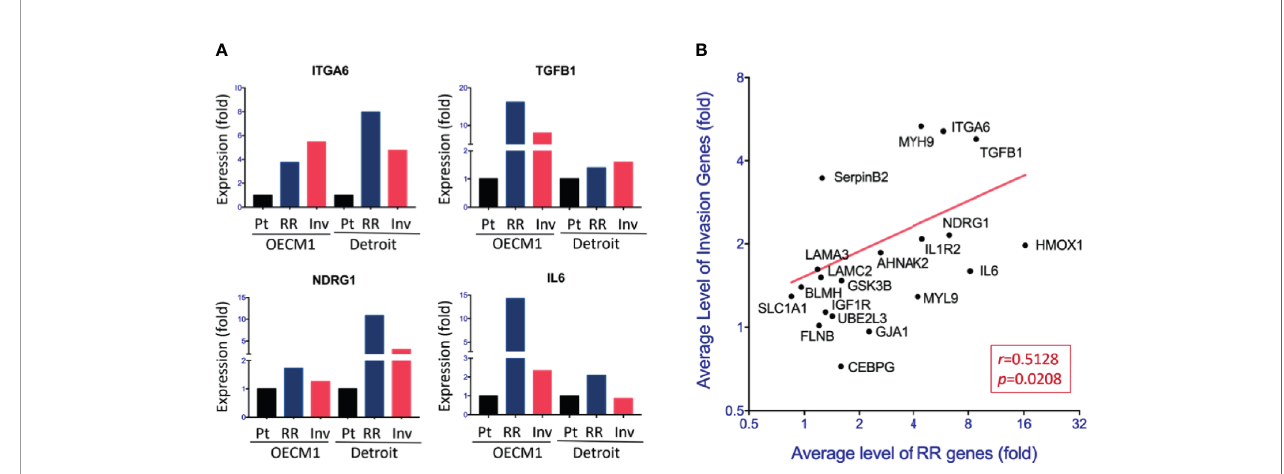
FIGURE 3 | Panel molecules correlative up-regulation in the invasion and radioresistant cells. (A) Relative levels of gene expressions among the parental (Pt) cells, radioresistant (RR) subline, and invasion (Inv) subline of the OECM1 and Detroit cell lines, by using RT-qPCR method. The expression levels are shown by bars. (B) Correlative expressions of 20 genes between RR subline and Inv subline of HNC cells. For each gene, the average level of the fold changes compared to the parental cells from two cell lines (OECM1 and Detroit) was